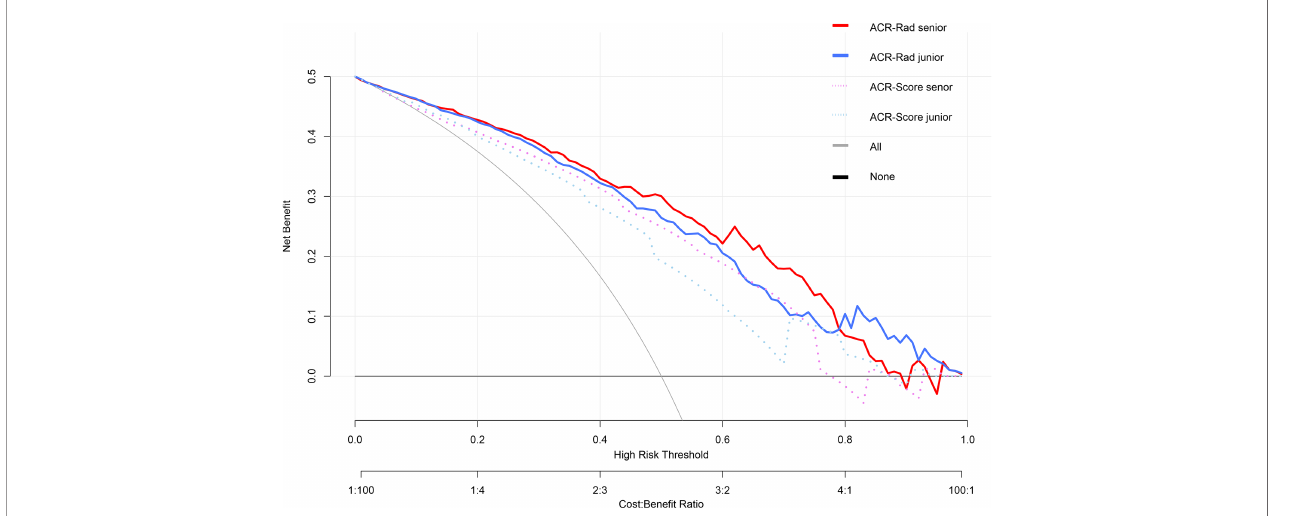
FIGURE 5 | Decision curve analysis (DCA) of the ACR-Rad nomogram in predicting malignancy in thyroid nodules for the senior and junior radiologists. The vertical axis measures standardized net bene fi t. The horizontal axis shows the corresponding risk threshold. The DCA showed that the ACR-Rad nomogram had a higher overall net bene fi t than the ACR-Score model for both senior and junior radiologist.